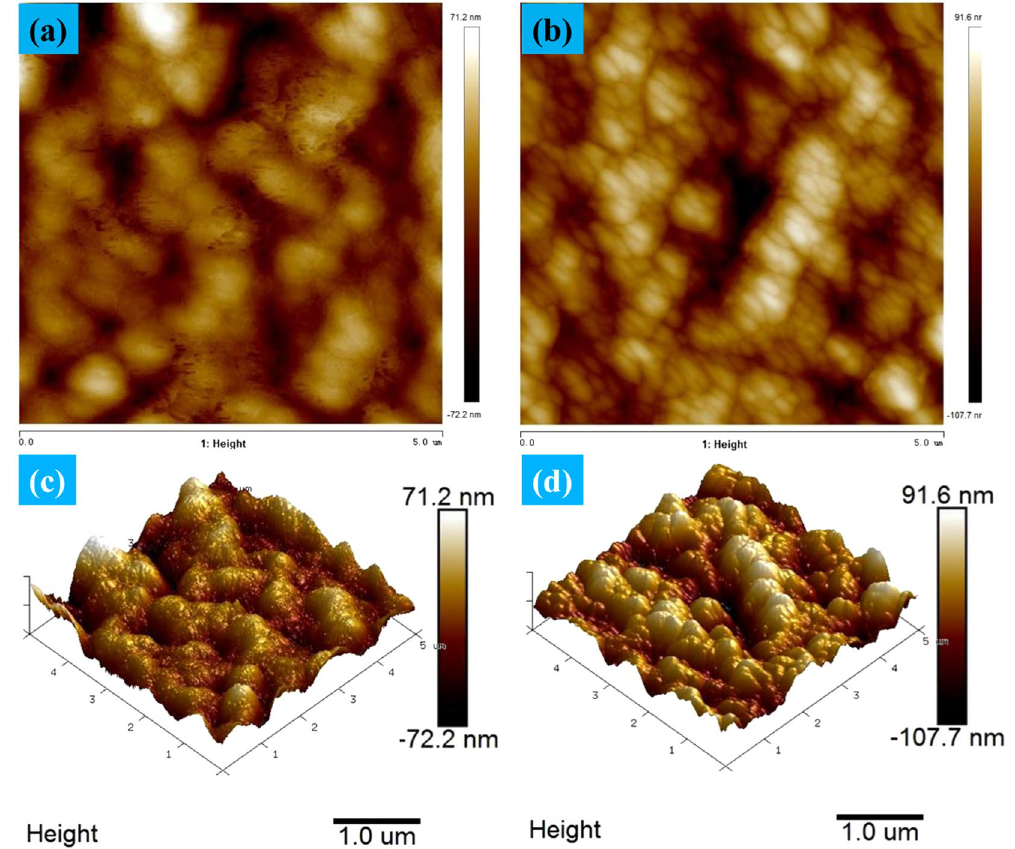
Figure 5. AFM images of the control and grafted membranes in top and perspective views: ( a ), ( c ) the control membrane; ( b ), ( d ) the grafted